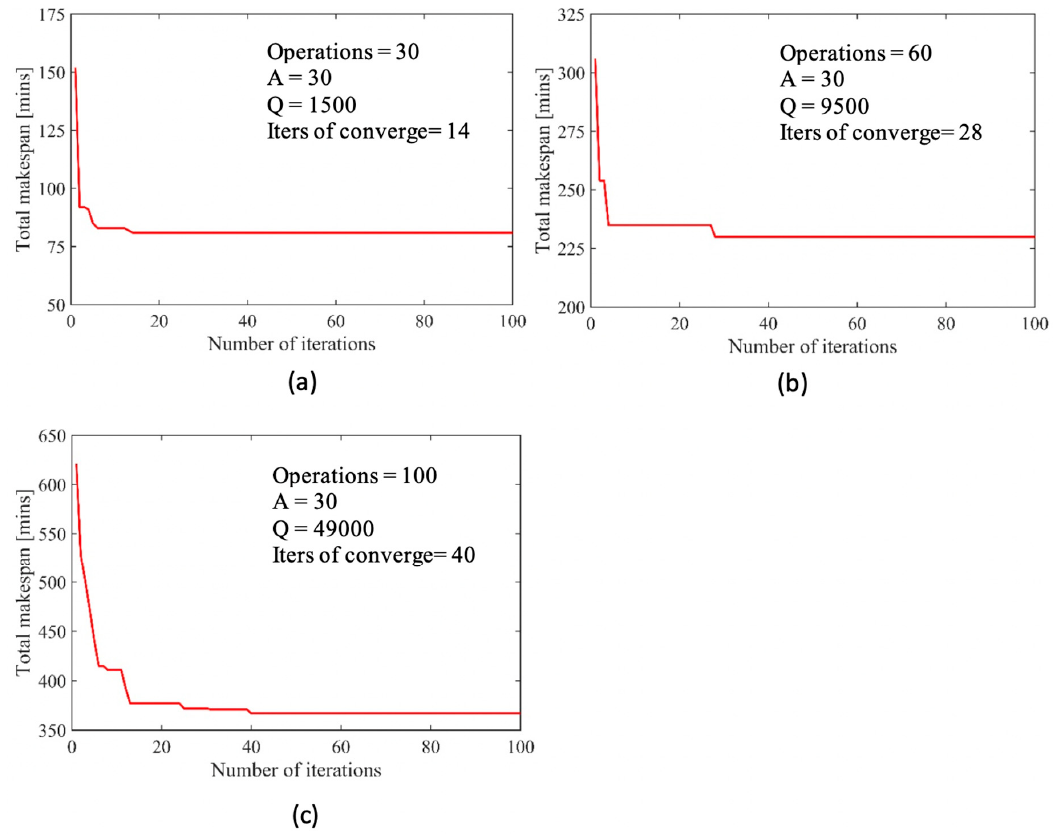
Figure 3. Convergence rate of the developed algorithm with different number of operations: ( a ) 30 operations, ( b ) 60 operations and ( c ) 100 operations.